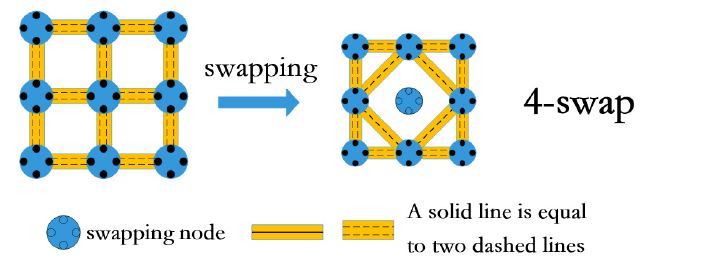
Figure 3. Effects of 4-swap on the structure of the underlying networks.